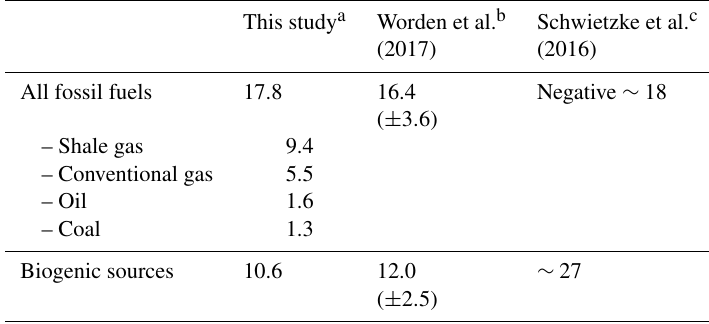
Table 1. Estimates for sources of increased or decreased methane emissions to the atmosphere in recent years (teragrams per year). All values are positive, except as specified.